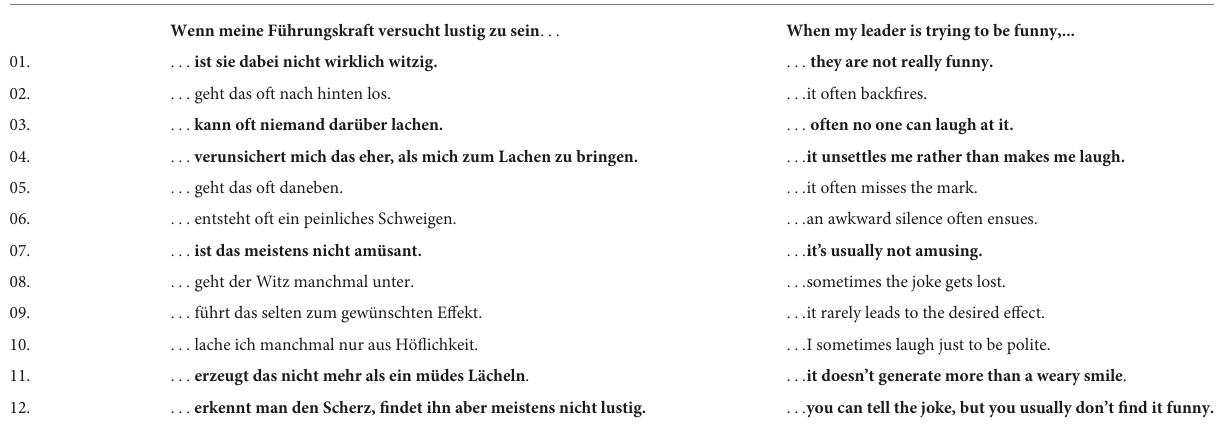
TABLE 1 Failed humor scale. Original German item wording English item